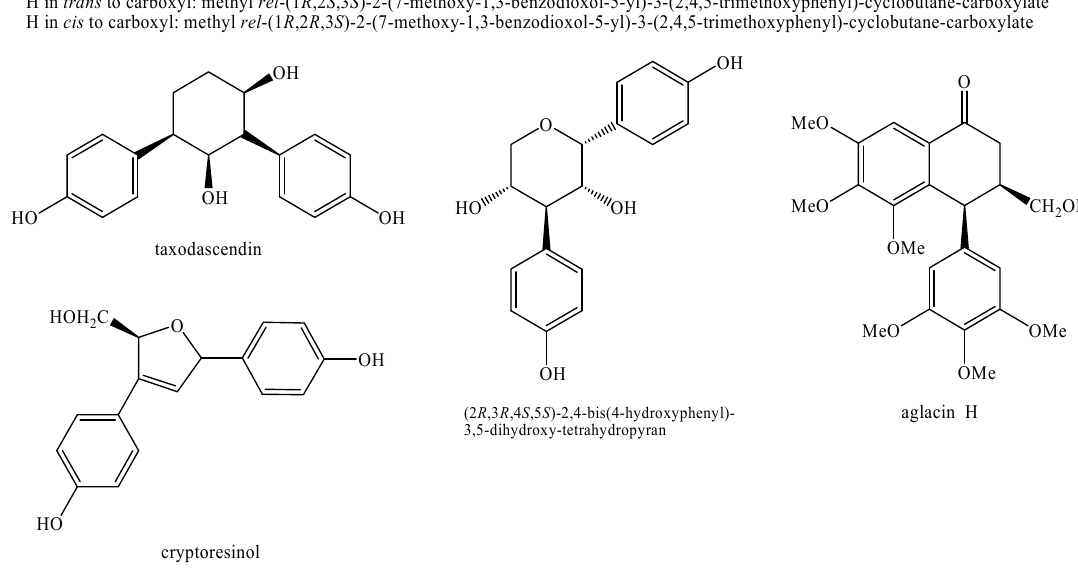
Figure 7. Isolated nor -lignans in the plant kingdom—part 6.